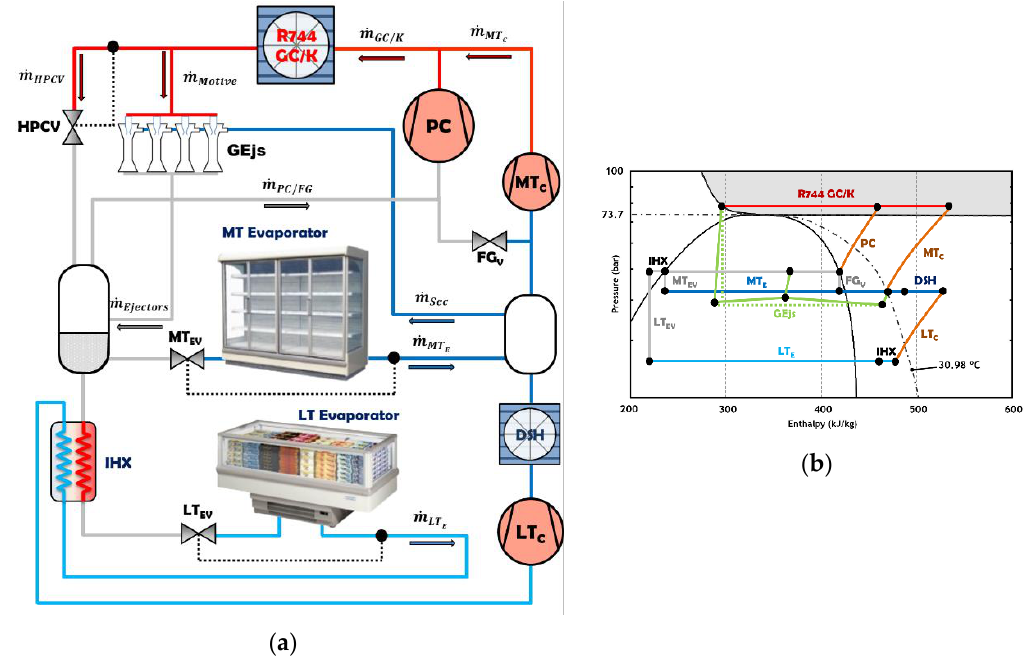
Figure 4. Schematic of a booster + PC ( a ) and its p–h diagram ( b ).